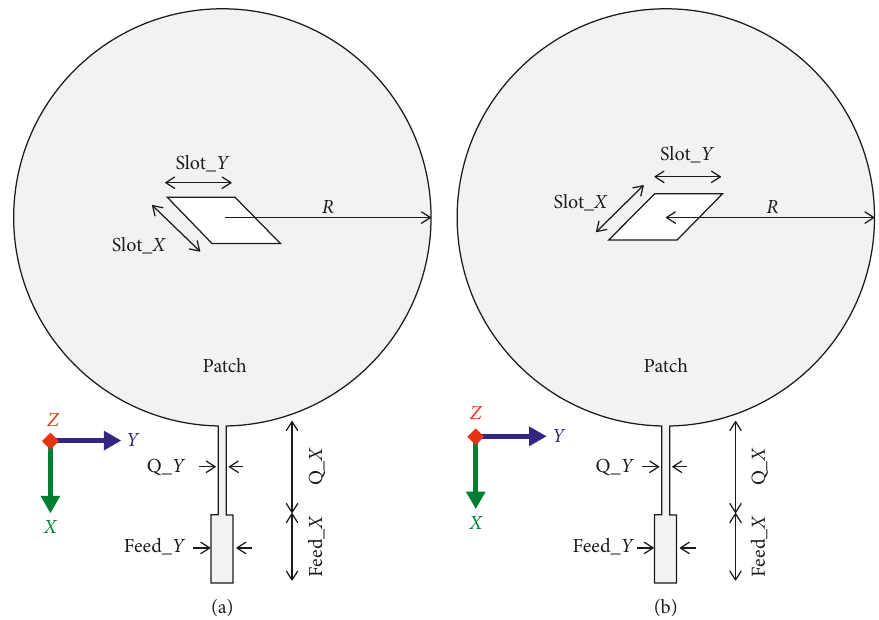
Figure 1: Antenna geometry. (a) LHCP. (b) RHCP.